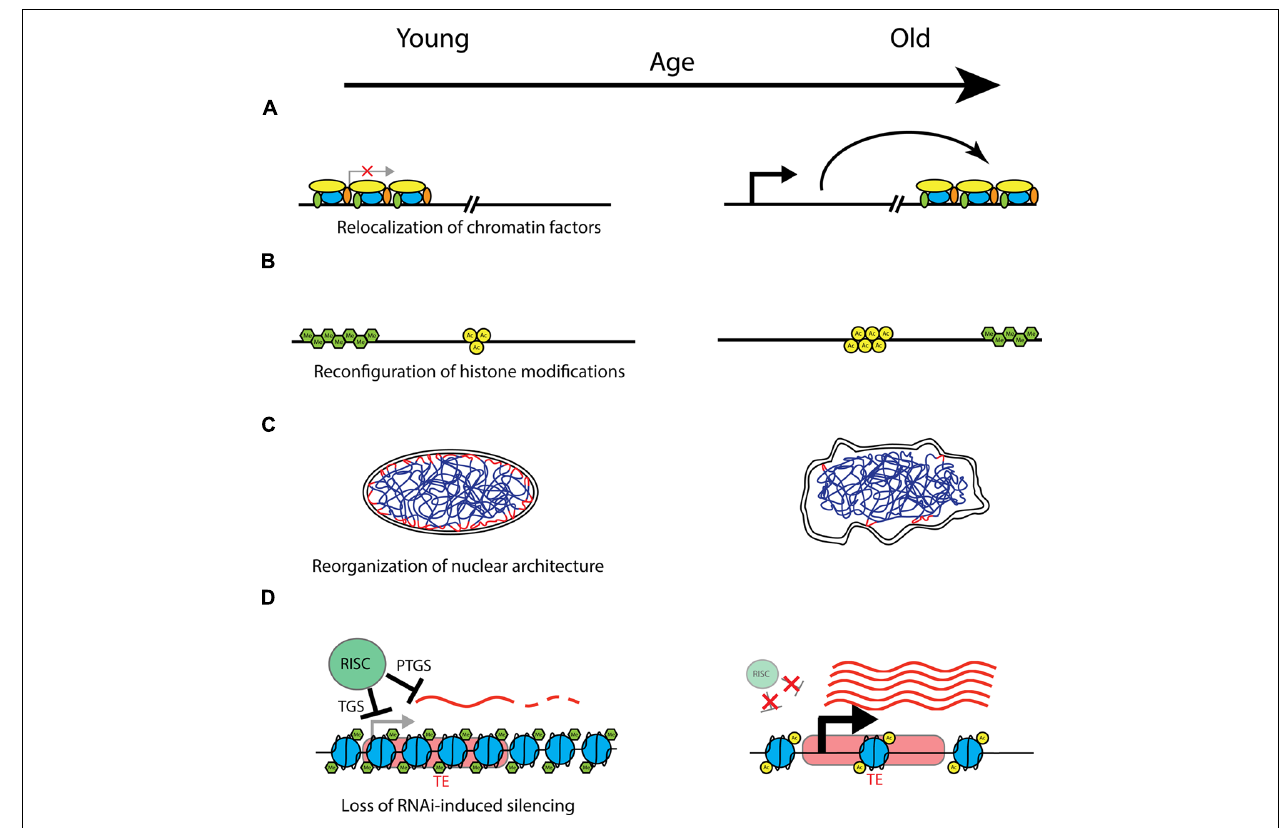
membrane. Degradation of nuclear architecture with age could lead to failure to maintain silent heterochromatin at LADs with age. (D) Model of transposable element (TE) derepression with age. In young healthy cells, transcription and expression fromTEs (represented here in red) is prevented by the RNAi machinery.The RNAi-induced silencing complex (RISC) performs transcriptional gene silencing (TGS) by recruiting chromatin remodeling factors and establishing refractory heterochromatin, shown here as densely packed nucleosomes with characteristic histone modifications (e.g., H3K9me3). Furthermore, any transcripts that are produced (represented by wavy red lines) are targeted for degradation by a posttranscriptional gene silencing (PTGS) mechanism also mediated by the RISC.With age, declines in the functionality or efficiency of small RNA processing and targeting may lead to a breakdown in these silencing mechanisms.The chromatin structure is modified, with characteristics of more actively expressed chromatin, such as fewer histone methylation (H3K9me) marks, and increased histone acetylation marks and chromatin accessibility. Additionally, loss of PTGS can lead to increased levels ofTE transcripts, which can undergo transposition and land in other areas of the genome, with deleterious